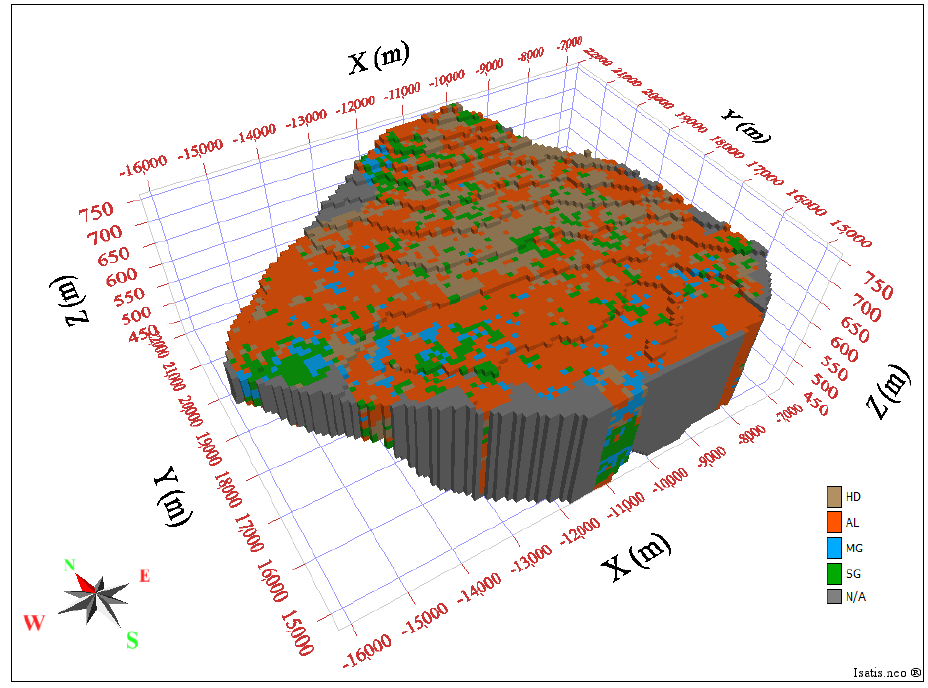
Figure 10. Overview of the PGS model.